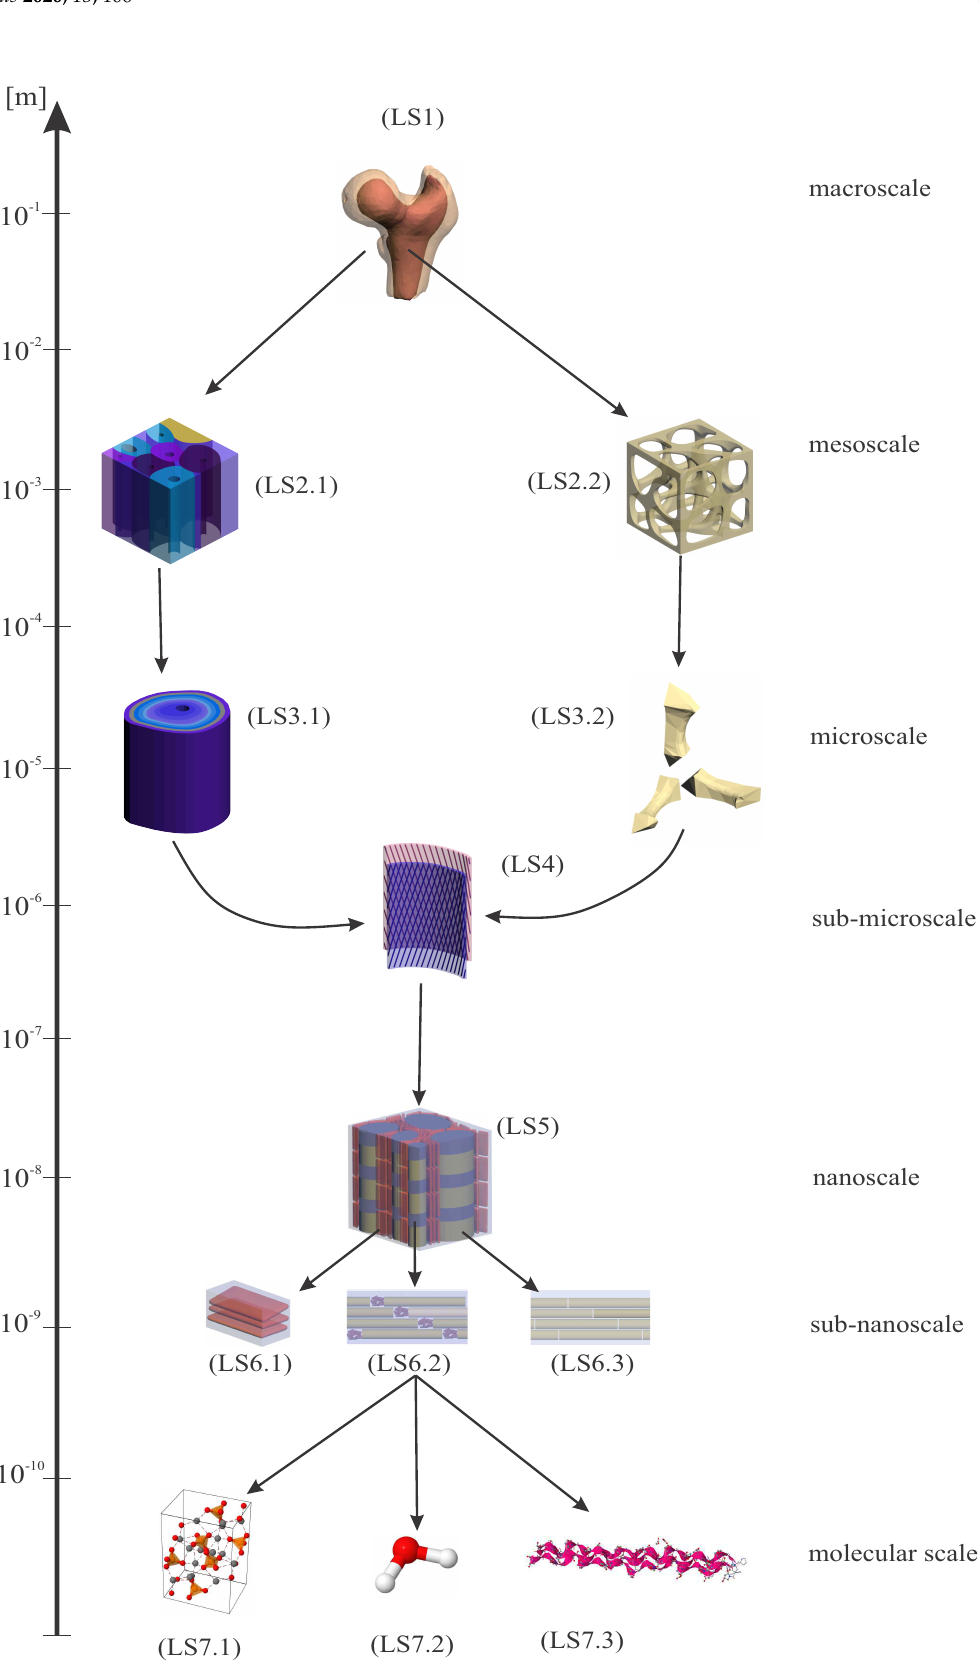
Figure 4. The multiscale structure of